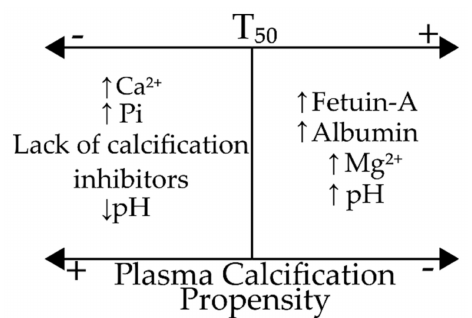
Figure 3. E ff ects of various factors upon T 50 (half of the time needed for the spontaneous transition from CPP I to CPP II) and plasma calcification propensity. Abbreviations: Pi, phosphate; Ca 2 + , calcium; Mg 2 + , magnesium.